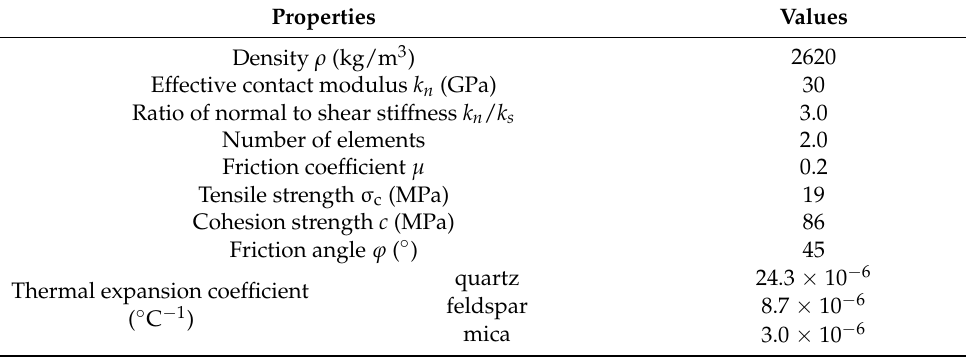
Table 2. Microparameters of numerical model.